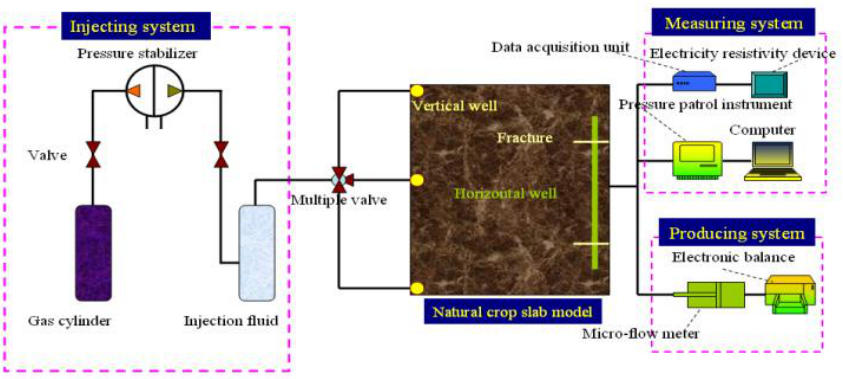
Figure 1—Flow diagram of physical simulation